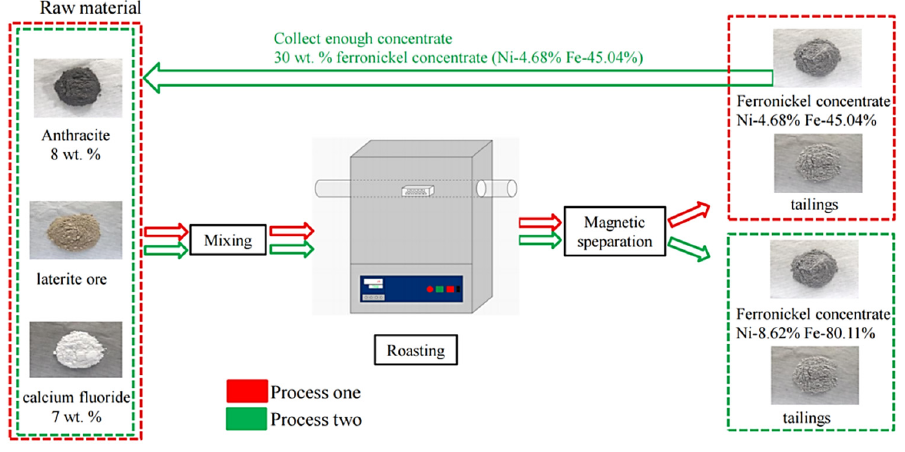
Figure 1. The flow chart of reduction roasting-magnetic separation experiment of laterite nickel ore.